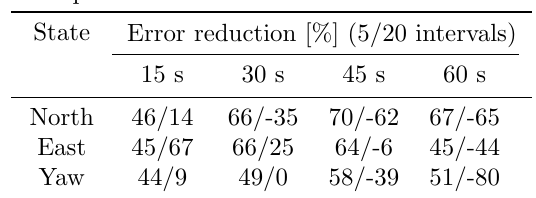
Table 3: Average reduction in error by applying the hybrid model relative to the dynamic model